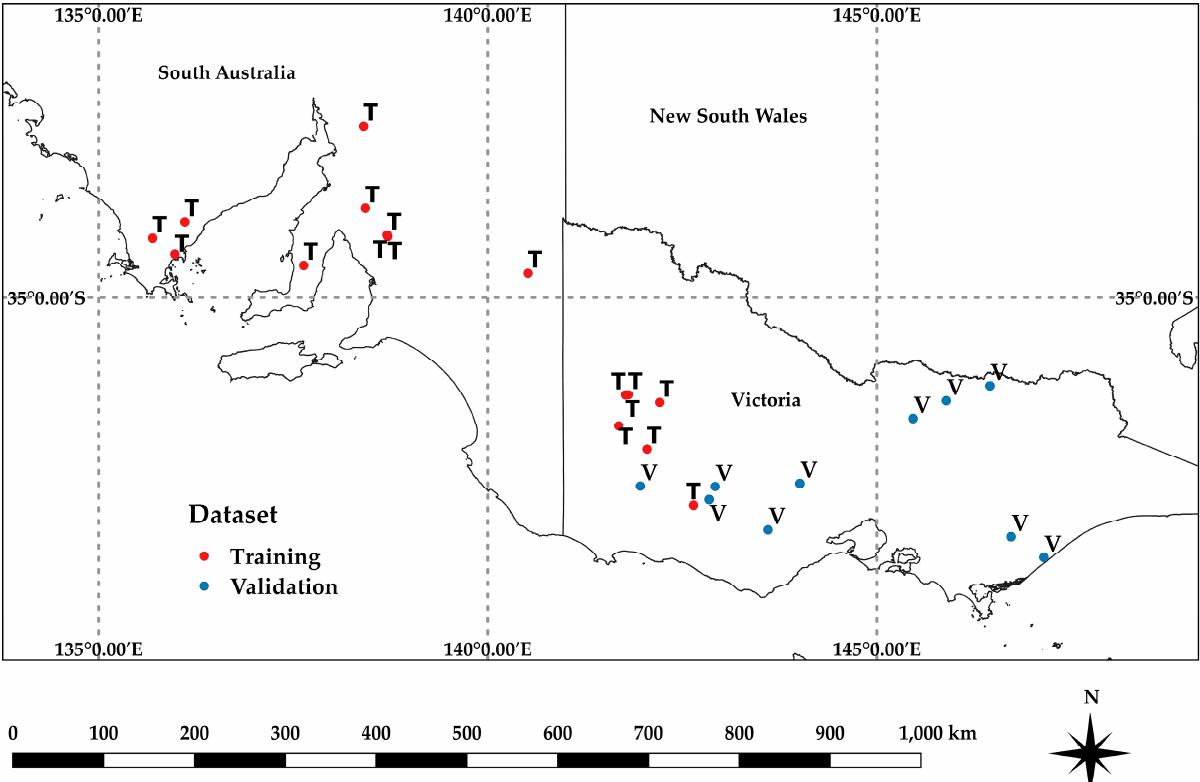
Figure 1. Locations for the Training and Validation datasets across broad acre cropping regions in southern Australia, as described in Table 1.